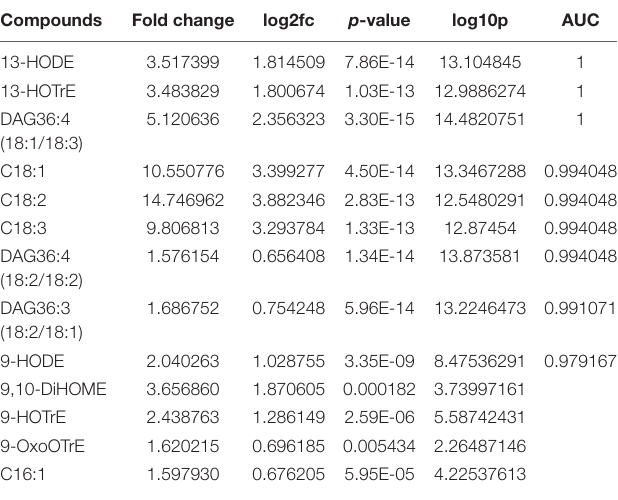
Supplementary Figure 15 ) was 13-HODE. Other